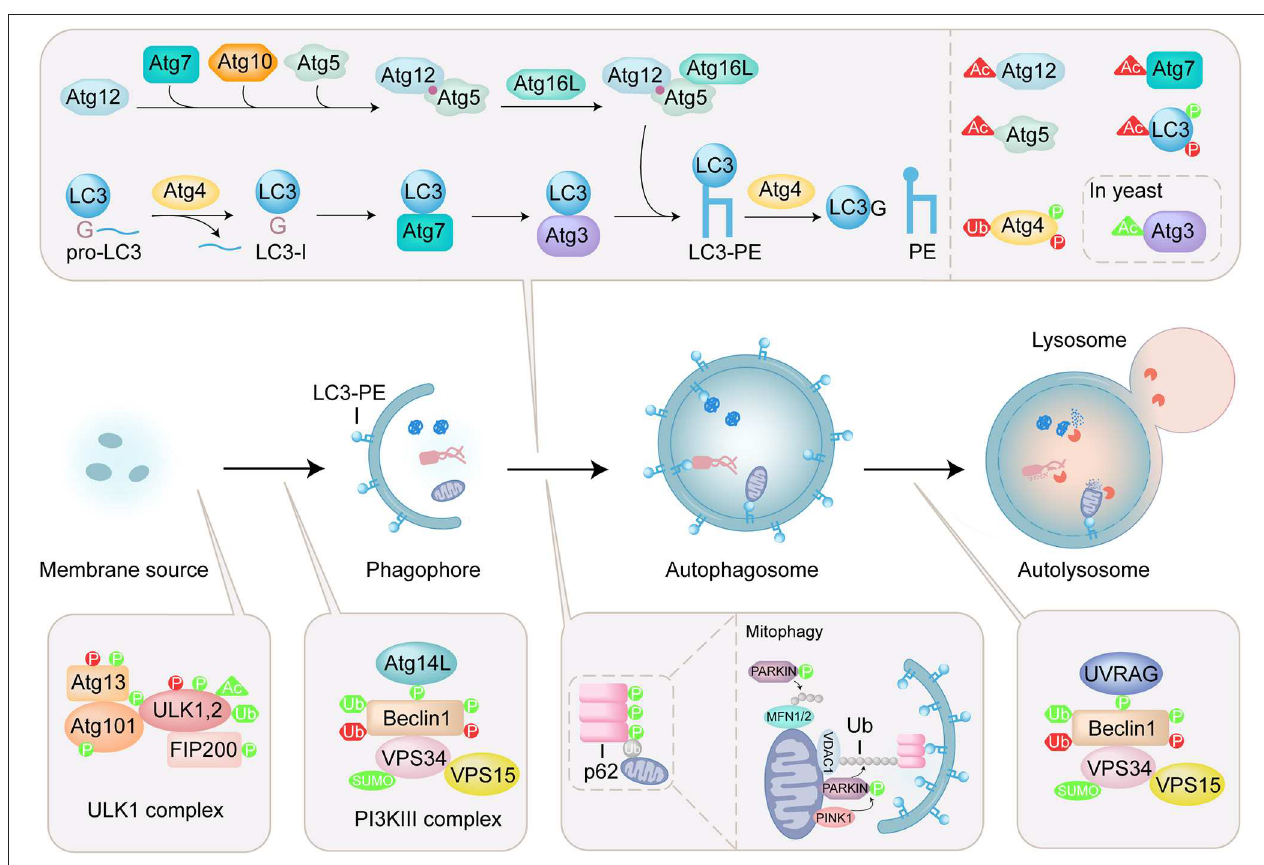
FIGURE 1 | Overview of autophagy process and regulation of ATG proteins by PTMs. Autophagy is a lysosomal degradation pathway that sequesters and engulfs cytoplasmic targets. The induction of autophagy is initiated by ULK complex which contains ULK1/2, autophagy-related (ATG) 13, focal adhesion kinase family interacting protein of 200 kDa (FIP200), and ATG101. The PI3KIII complex containing Beclin1, ATG14L, vacuolar protein sorting (VPS) 34, and vacuolar protein sorting 15 (VPS15) is activated by ULK1 initiates formation of phagophore. Two ubiquitin-like (Ubl) conjugation systems (Atg12 conjugation system and LC3 lipidation system) mediate the elongation and closure of the autophagosome. The maturation of the autophagosome and the fusion with the lysosome are mediated by the PI3KIII complex containing Beclin1, UV radiation resistance-associated gene product (UVRAG), vacuolar protein sorting (VPS) 34, and vacuolar protein sorting 15 (VPS15). Autophagy receptor, such as p62, specifically recognizes ubiquitinated substrates and binds to LC3-PE. In mitophagy, PINK1 is stabilized on the outer mitochondrial membrane and activated by autophosphorylation, triggering Parkin recruitment and activation. Then mitochondrial surface proteins, such as voltage-dependent anion-selective channel protein 1 (VDAC1) and mitofusins (MFN1/2) are ubiquitinated by Parkin, modulating mitochondrial dynamics. The PTMs including phosphorylation (P), acetylation (Ac), ubiquitination (Ub) and sumoylation (SUMO) are shown on ATG proteins. PTMs that positively regulate the autophagy process are in green, and those that negatively regulate the autophagy process are in